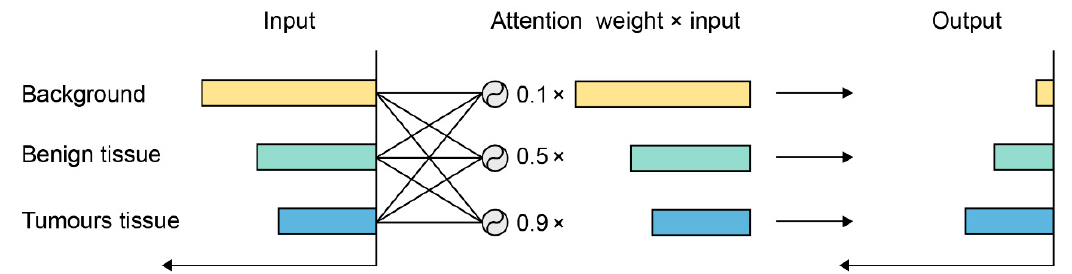
Figure 6. An example of the attention mechanism. The response to input is reweighted by the attention mechanism.